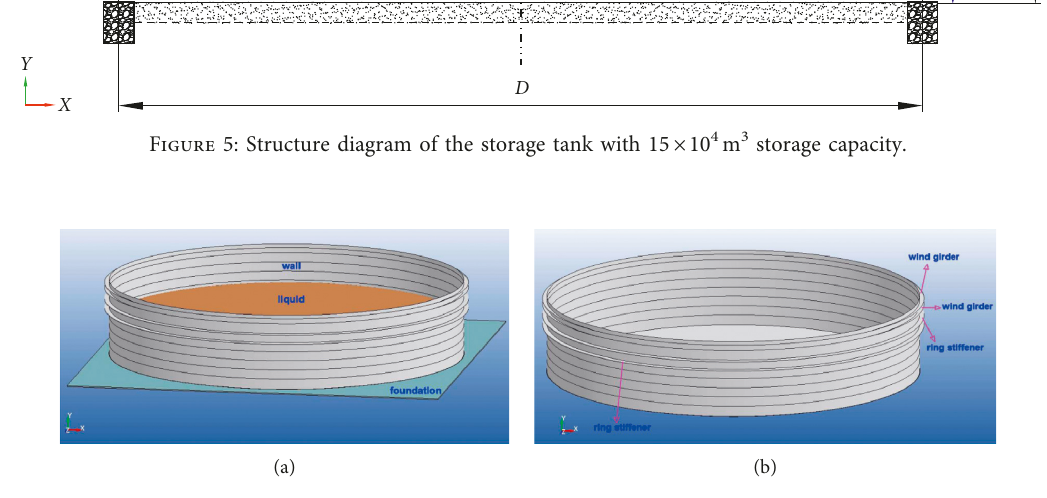
Figure 6: Storage tank and inner liquid. (a) A storage tank with liquid. (b) Wind girders and ring stiffeners.